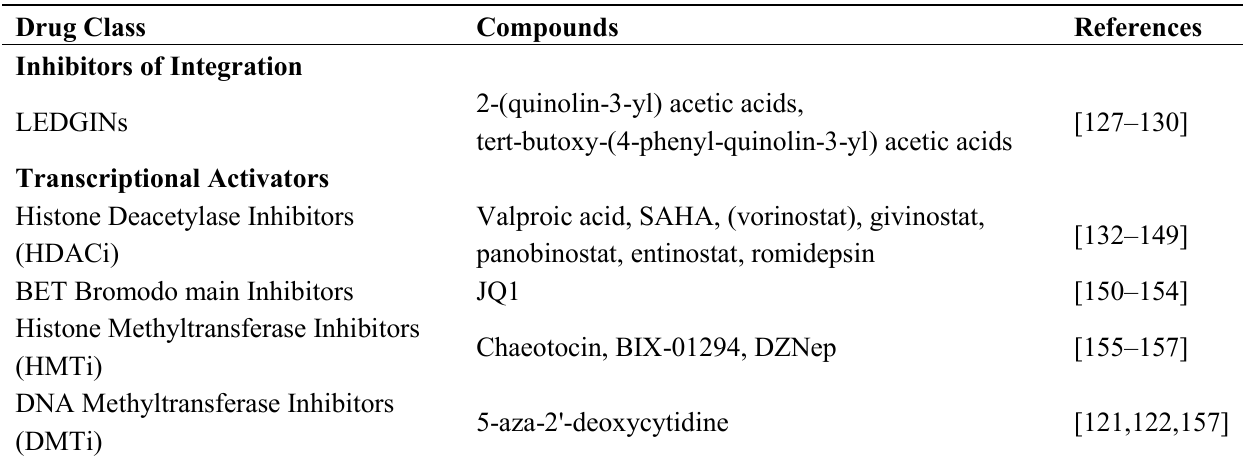
Table 1. Potential HIV therapeutics that target